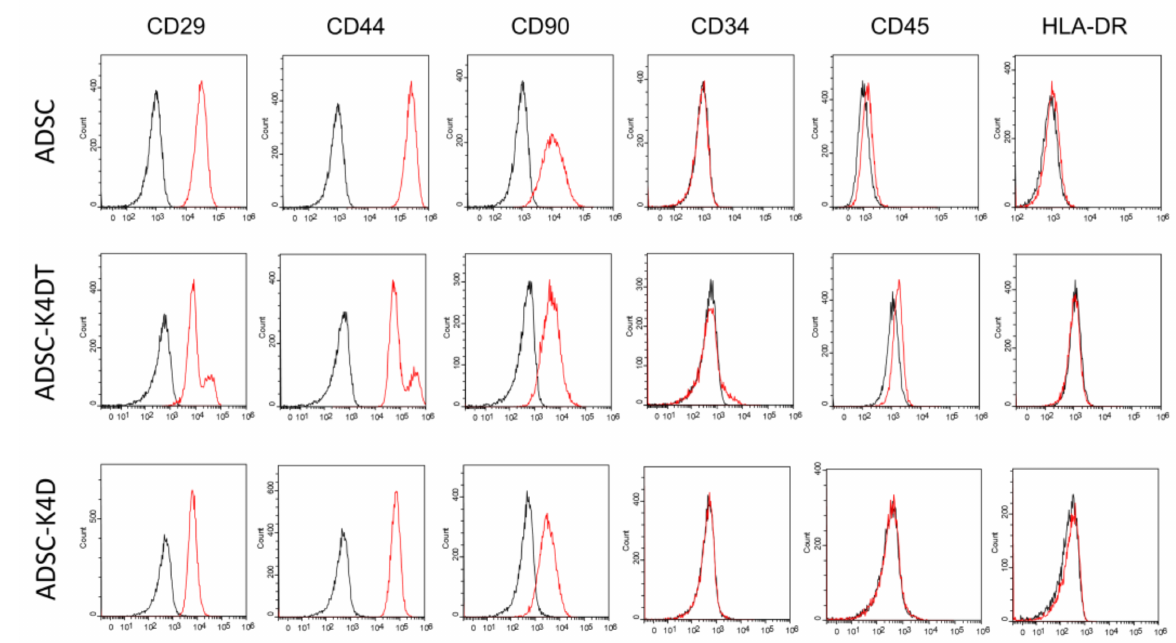
Figure 3. Expression of cell surface markers analyzed with flow cytometry. The primary ADSCs at passage 3, and the ADSC-K4DT and ADSC-K4D cells after antibiotic selection are shown. Black lines represent isotype controls, and red lines indicate each cell line.